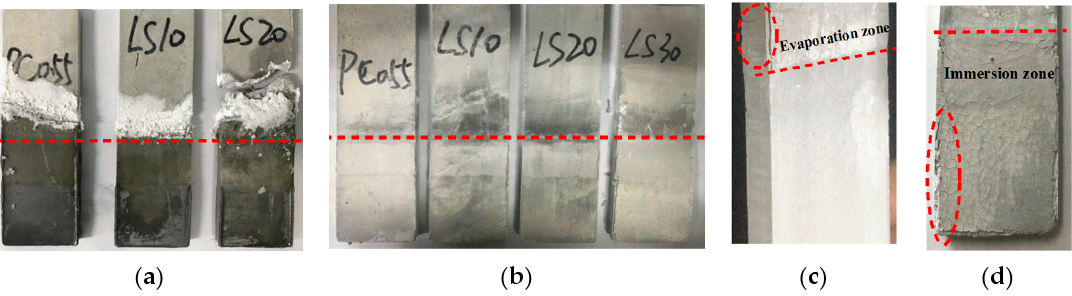
Figure 3. Damage characteristics of specimens partially immersed for 80 days, under different environments. ( a ) In air, ( b ) in N 2 , ( c ) PC in N 2 , and ( d ) LS30 in N 2.